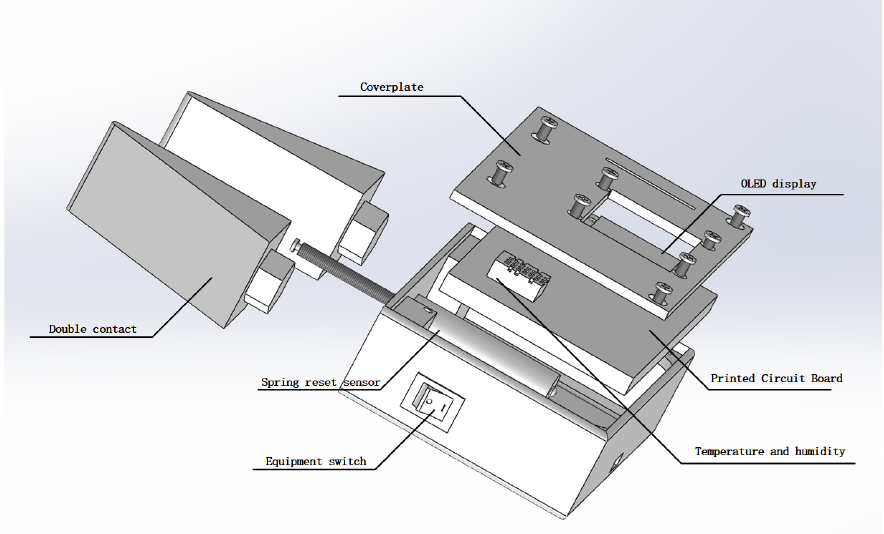
Figure 1. Mechanical structure diagram of the new standing wood DBH measuring